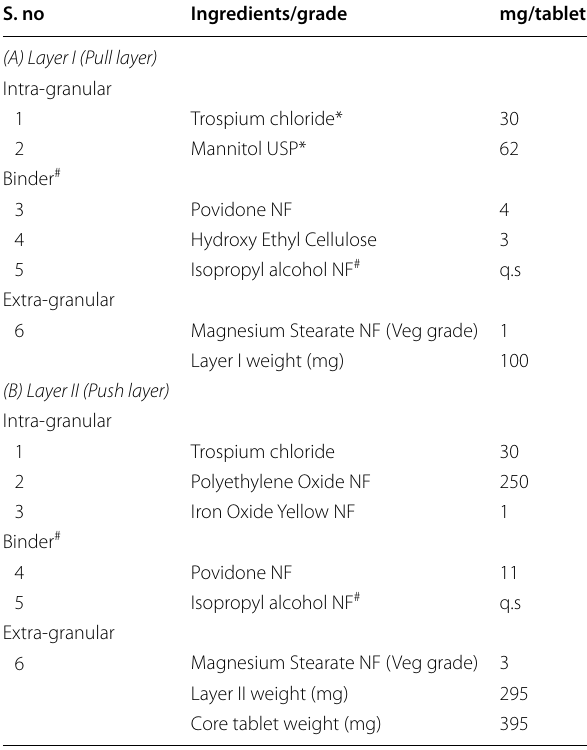
Table 1 Composition of trospium chloride push–pull